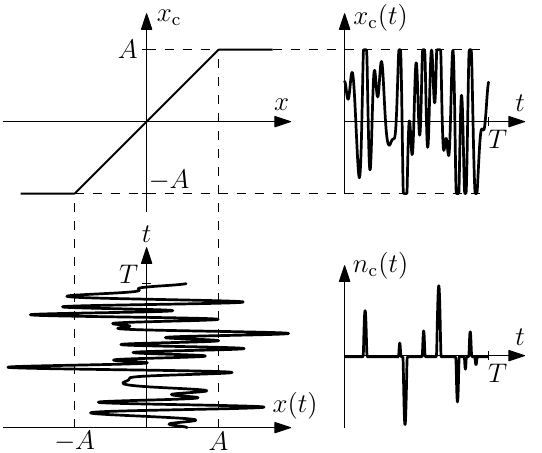
Figure 7. The clipping distortion n c ( t ) can be modeled as a sum of shifted parabolic arcs. The clipped signal x c ( t ) is equal to the input signal x ( t ) minus the distortion n c ( t )